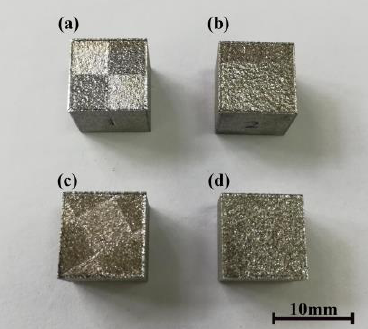
Figure 5. Testing sample of densification: ( a ) normal partition strategy; ( b ) oblique line and layer-staggered divisional strategy; ( c ) spiral divisional strategy; ( d ) “s”-style orthogonal scanning strategy.